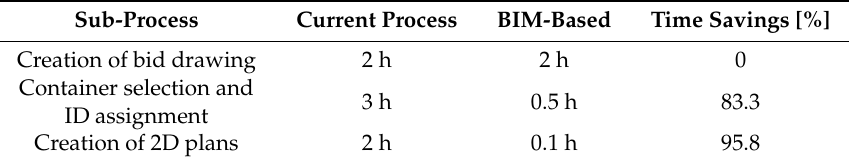
Table 2. Comparison of process durations: Current process vs. BIM-based.